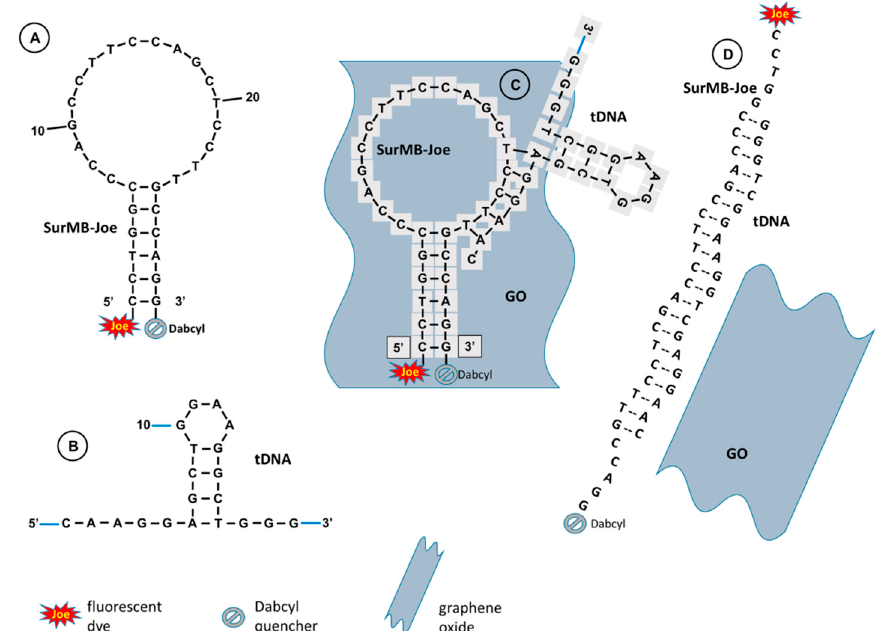
Figure 1. Structures and sequences of ( A ) survivin molecular beacon with a fluorophore Joe (SurMB-Joe) and ( B ) target oligonucleotide (tDNA) complementary to loop of MB; ( C , D ) Principle of molecular beacon operation, interactions of SurMB-Joe with GO and tDNA.